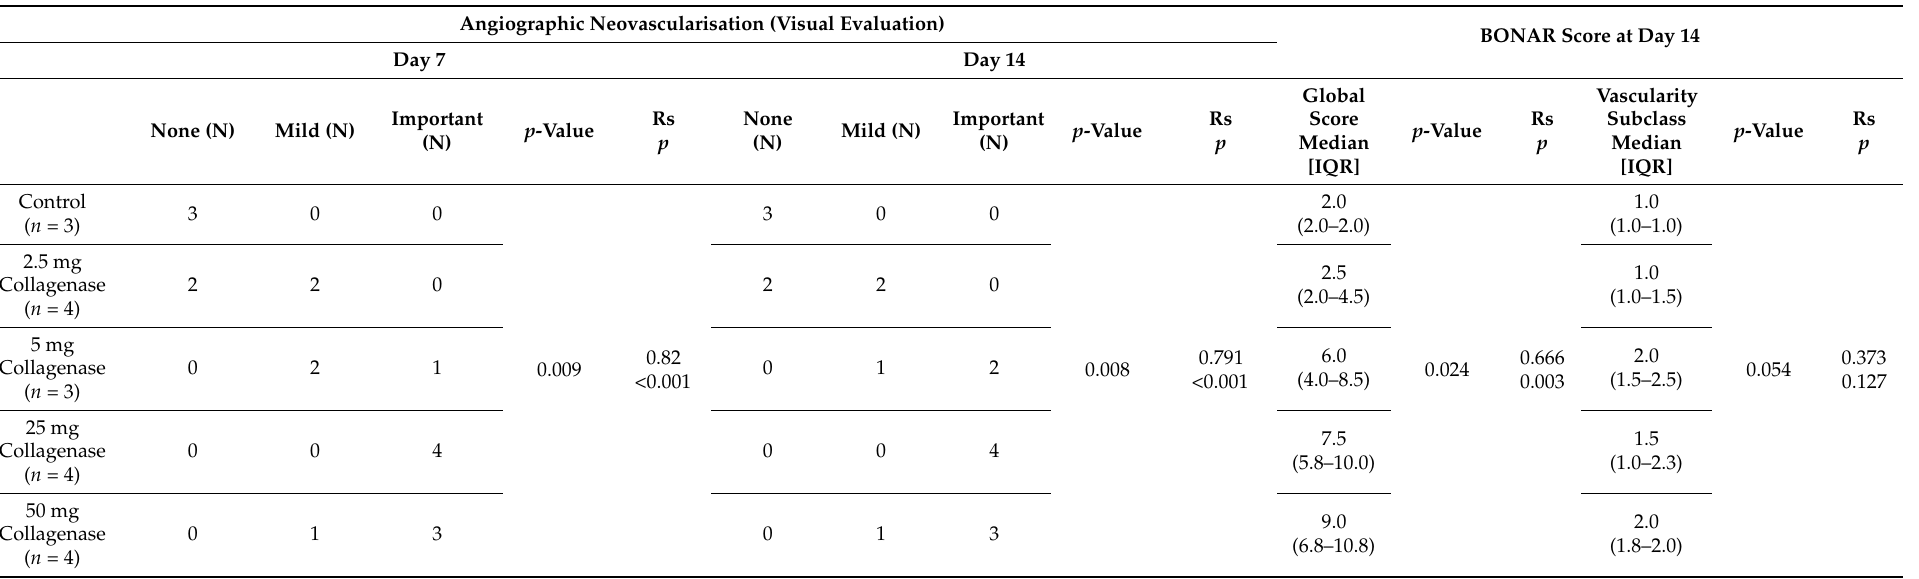
Table 2. Angiographic neovascularization evaluation on patellar tendon at D7 and D14 after model induction and Bonar score after